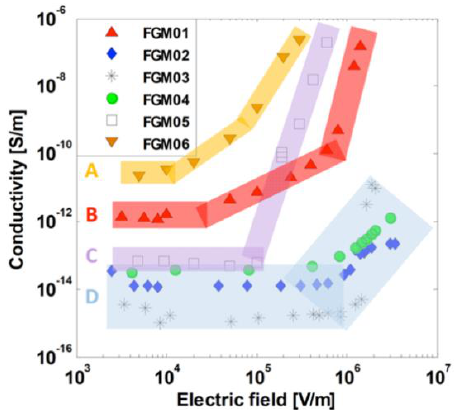
Figure 31. Log – log plot of DC conductivity at 30 °C vs. electric field of the field-grading materials with different compositions. © 2021 IEEE. Reprinted, with permission, from Ref. [53].